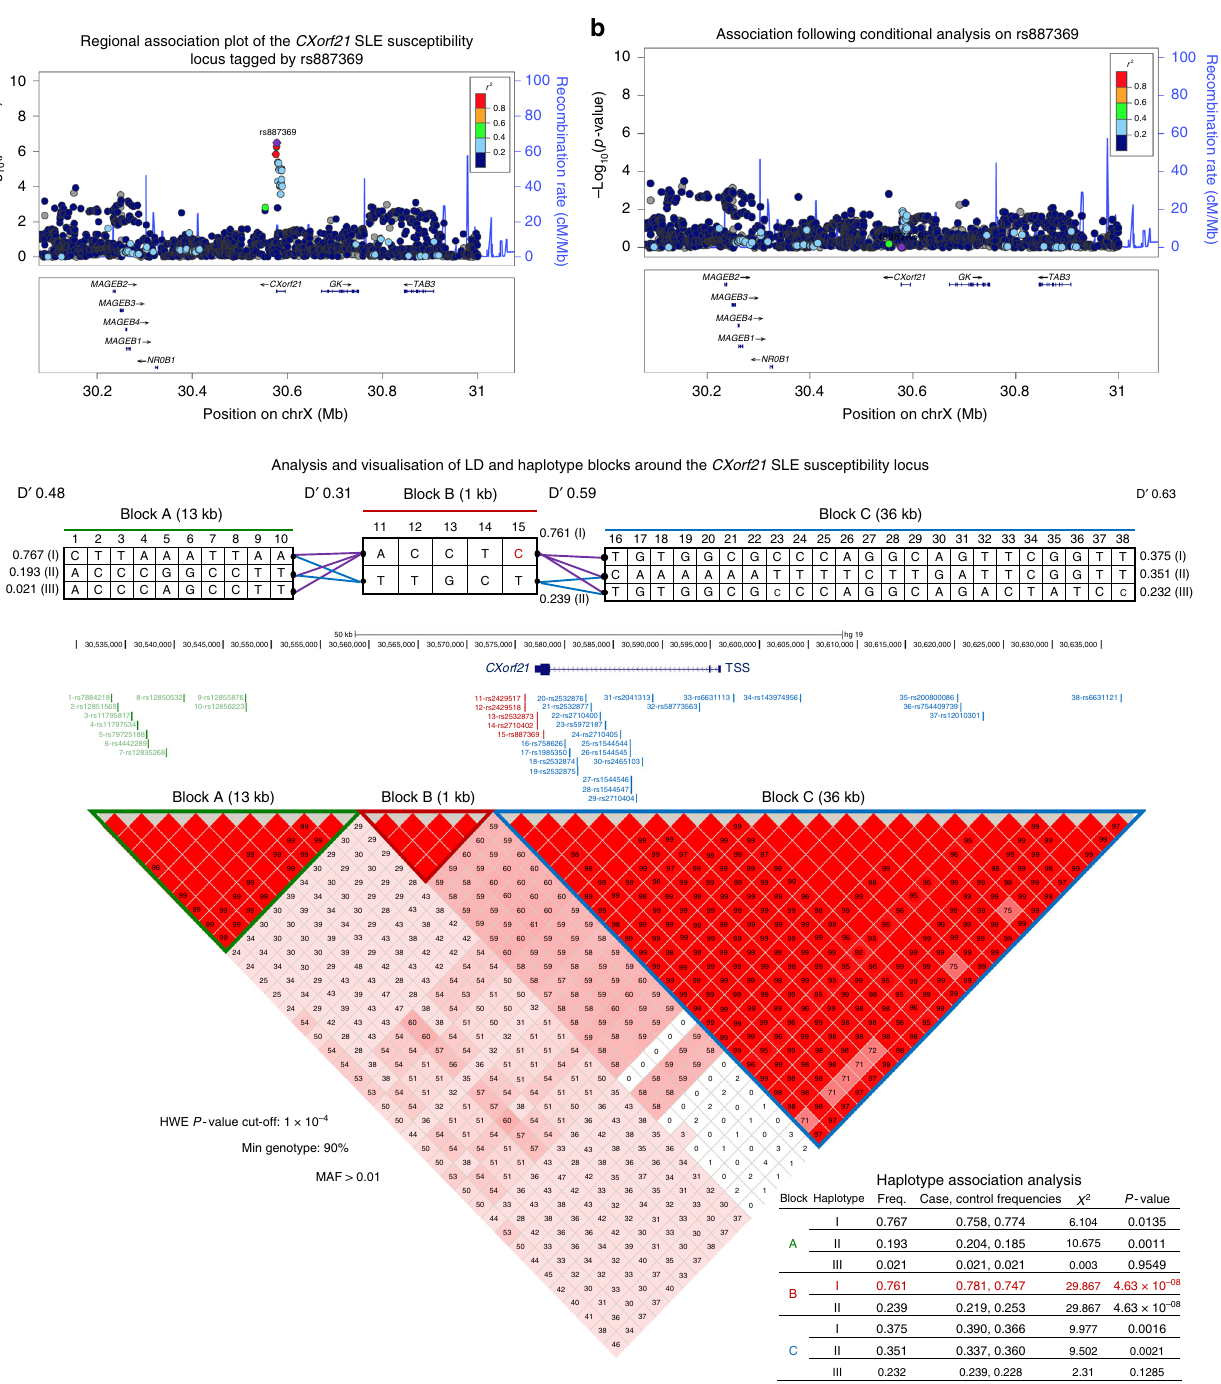
Fig. 1 Genetic re fi nement of the Xp21.2 (rs887369) SLE susceptibility locus. a Association plot of the 1 Mb region (X:30,077,846 – 31,077,845) of SLE- associated region Xp21.2 following genotype imputation to the level of UK10K-1000G Phase III and association testing as described ( n = 10,995 individuals of European ancestry). rs887369 is shown as the most signi fi cantly associated lead SNP. Genetic association plots were generated using LocusZoom. b Association plot of the 1 Mb region following conditional analysis on lead SNP rs887369. c Haplotype construction and visualisation of the Xp21.2 SLE susceptibility locus conducted in Haploview 4.2. The top panel shows the structure of the three blocks and haplotypes surrounding the lead SNP rs887369 (highlighted in red, block B, SNP #15). Blocks are separated by regions of high recombination as speci fi ed by D ′ and r 2 . The frequency of each haplotype is denoted. The middle panel presents the colour-coded haplotypes and individual SNPs by their genomic coordinates around CXorf21 . The bottom panel shows the LD structure and pair-wise correlation ( r 2 ) of SNPs, and length of each block. d Right table: case – control association analysis of each haplotype using Haploview